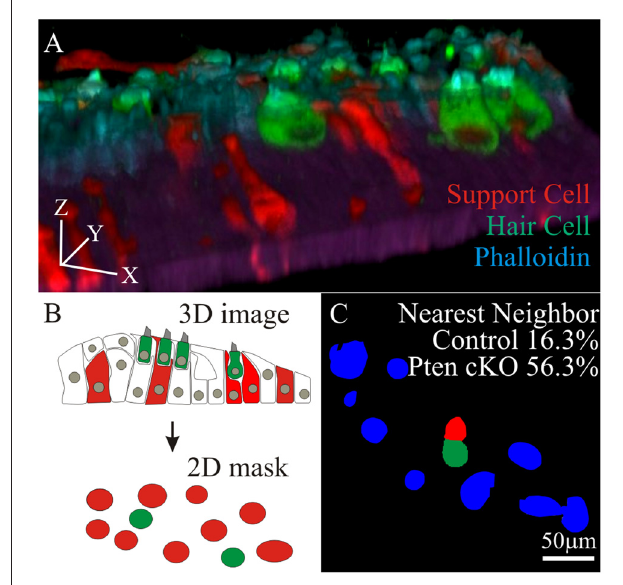
FIGURE 6 | Nearest neighbor analysis of supporting cell to surviving hair cells. (A) 3D rendering of a confocal stack with MYO7A and phalloidin labeled hair cells along with tdTomato labeled supporting cell (B) 3D images were compressed into a maximal intensity projection to generate a 2D mask for hair cells (green) and tdTomato labeled supporting cells (red). (C) Using the 2D masks, percent of surviving hair cells (green) that reside adjacent to supporting cells (red) were determined in control ( n = 4) and Pten cKO cochleae ( n = 4). All remaining cells in the field of view were labeled